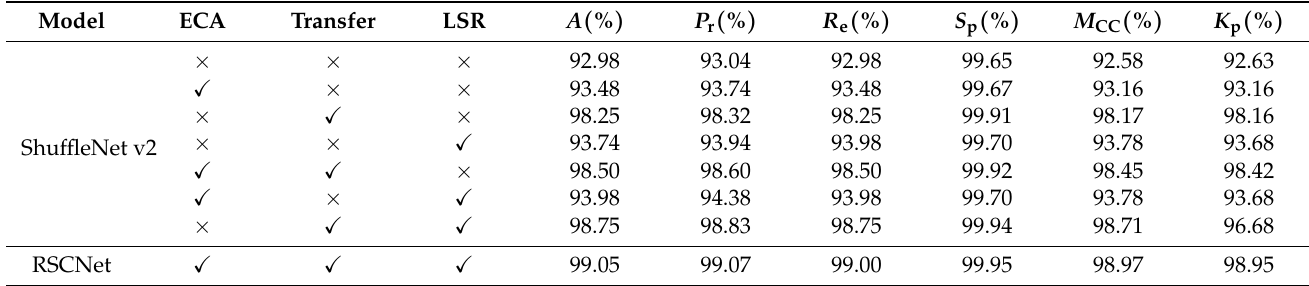
Table 6. Test results of the proposed method on the UCMerced_LandUse dataset. The training data ratio is